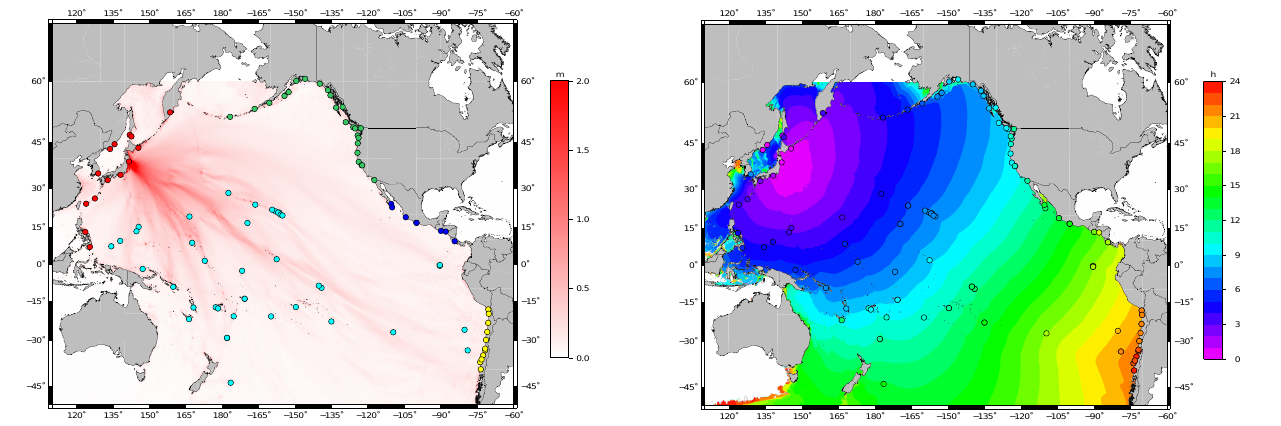
Fig. 1b. Computed tsunami travel times (TTT) for the tsunami lead- ing wave, that reaches the farthest stations in more than 23h. TTT is derived from numerical tsunami simulation and is defined here as the minimum propagation time for which the modulus of the sea surface elevation exceeds 2cm in deep sea (depth larger than 1000m). Station circles are colored according to the associated ob- served TTT, which makes it easier to recognize possible discrepan- cies between observed and computed